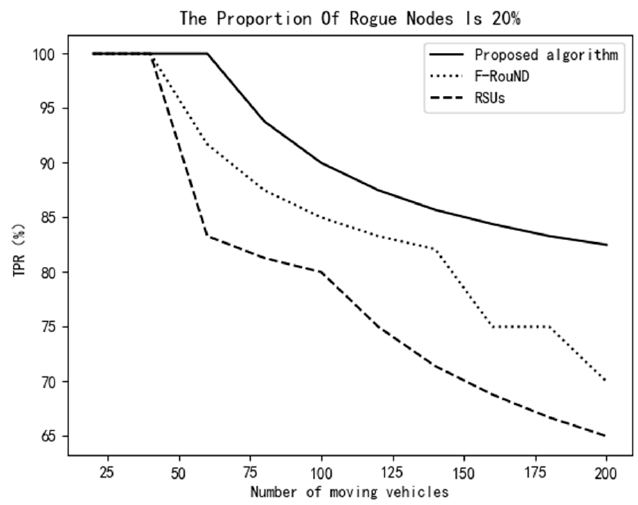
Figure 9. Variation of TPR vs. the number of mobile vehicles (20%).